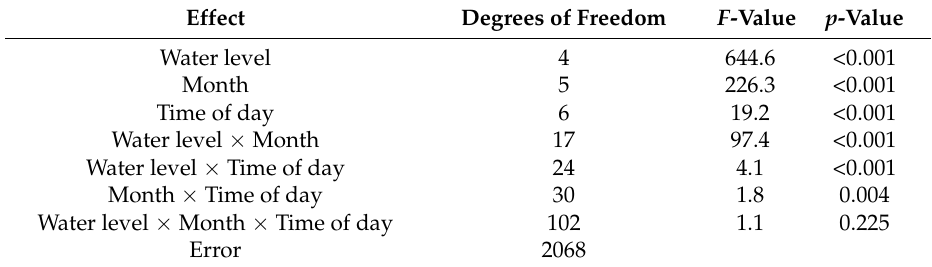
Table 2. ANOVA table to test the effects of water level, sampling month and time of day on CO 2 flux.